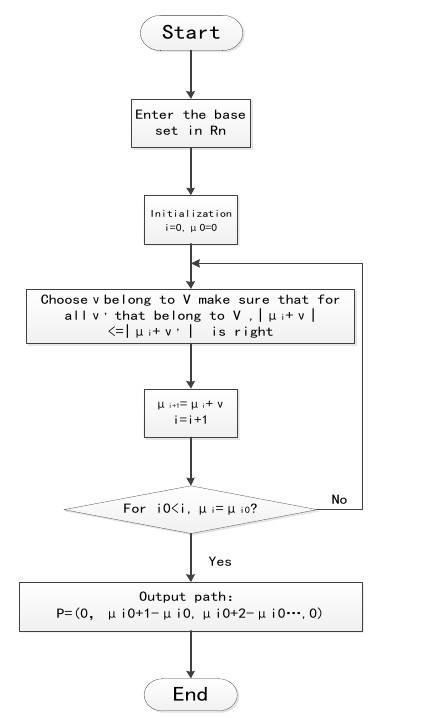
Figure 5. Schematic diagram of the overall effect of the Henan provincial boundary in the rectangle